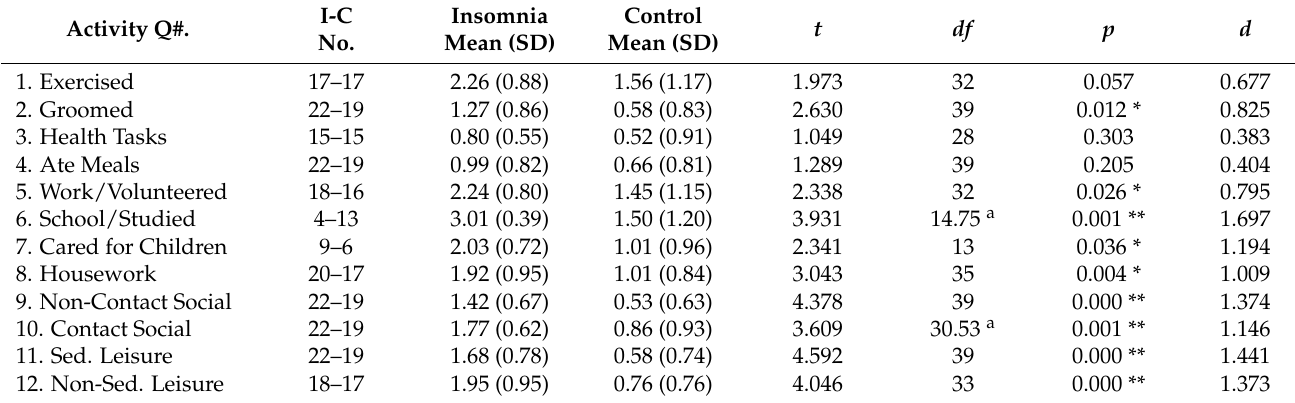
Table 3. Effort scores for all 12 SIAD activities between insomnia and control